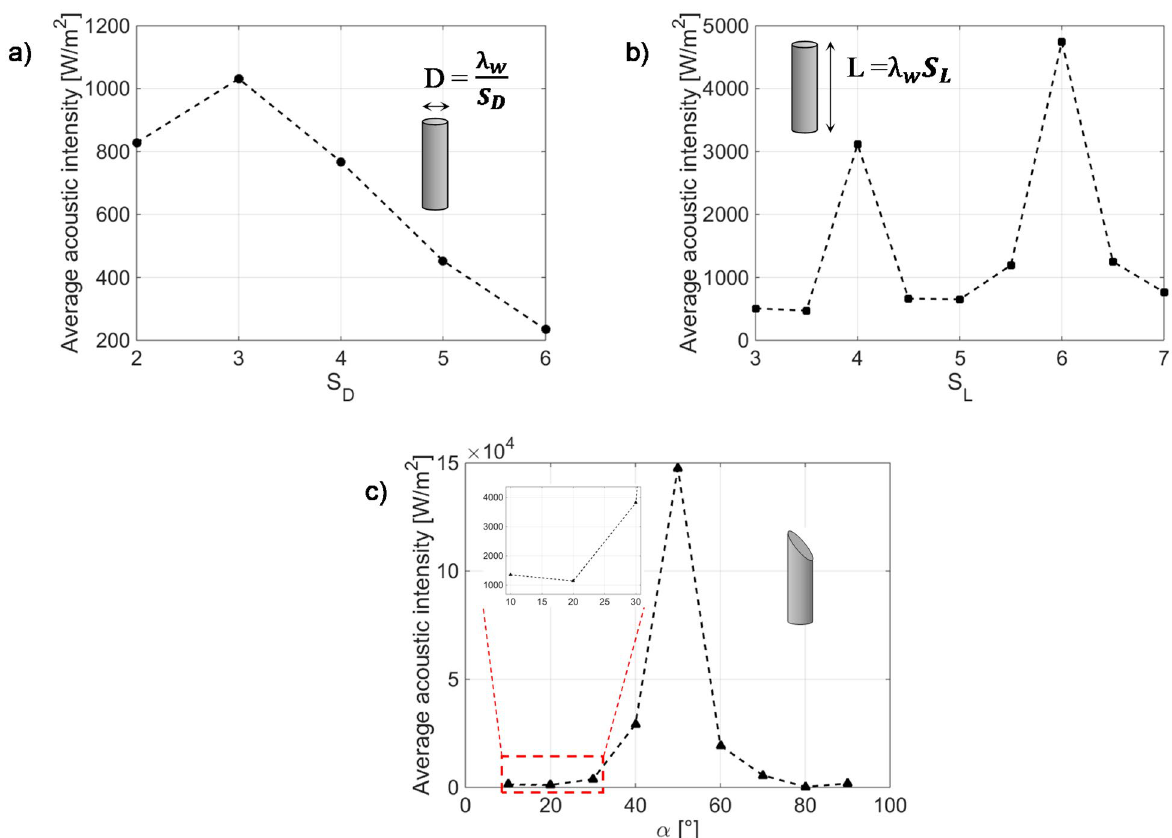
Figure 6. Average acoustic intensity coming out from the needle tip (considered flat) as a function of the needle internal diameter ( a ), length ( b ), and bevel angle α ( c ). The length in ( a,c ) is 90 mm, and the diameter in ( b,c ) is 3